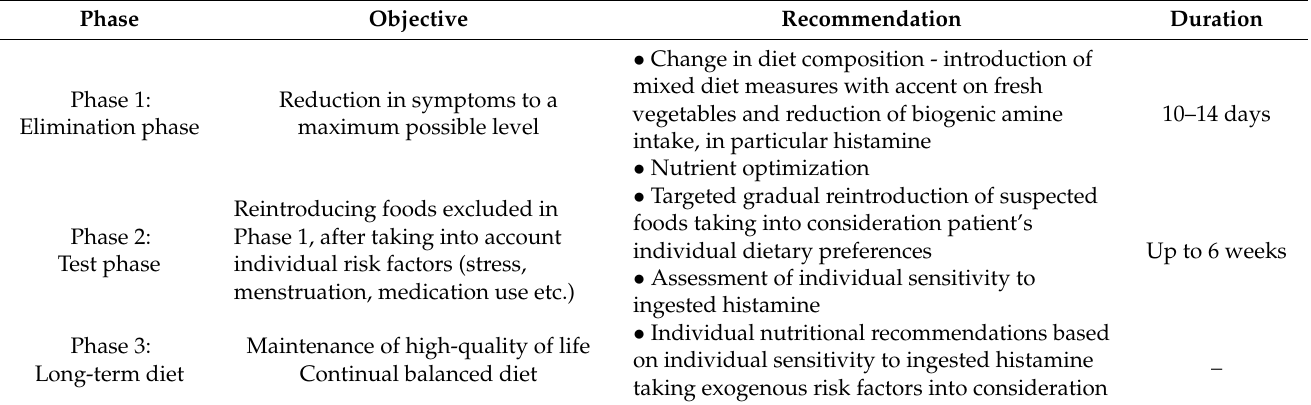
Table 5. Phases of dietary measures in patients with suspected HIT. Adapted according to